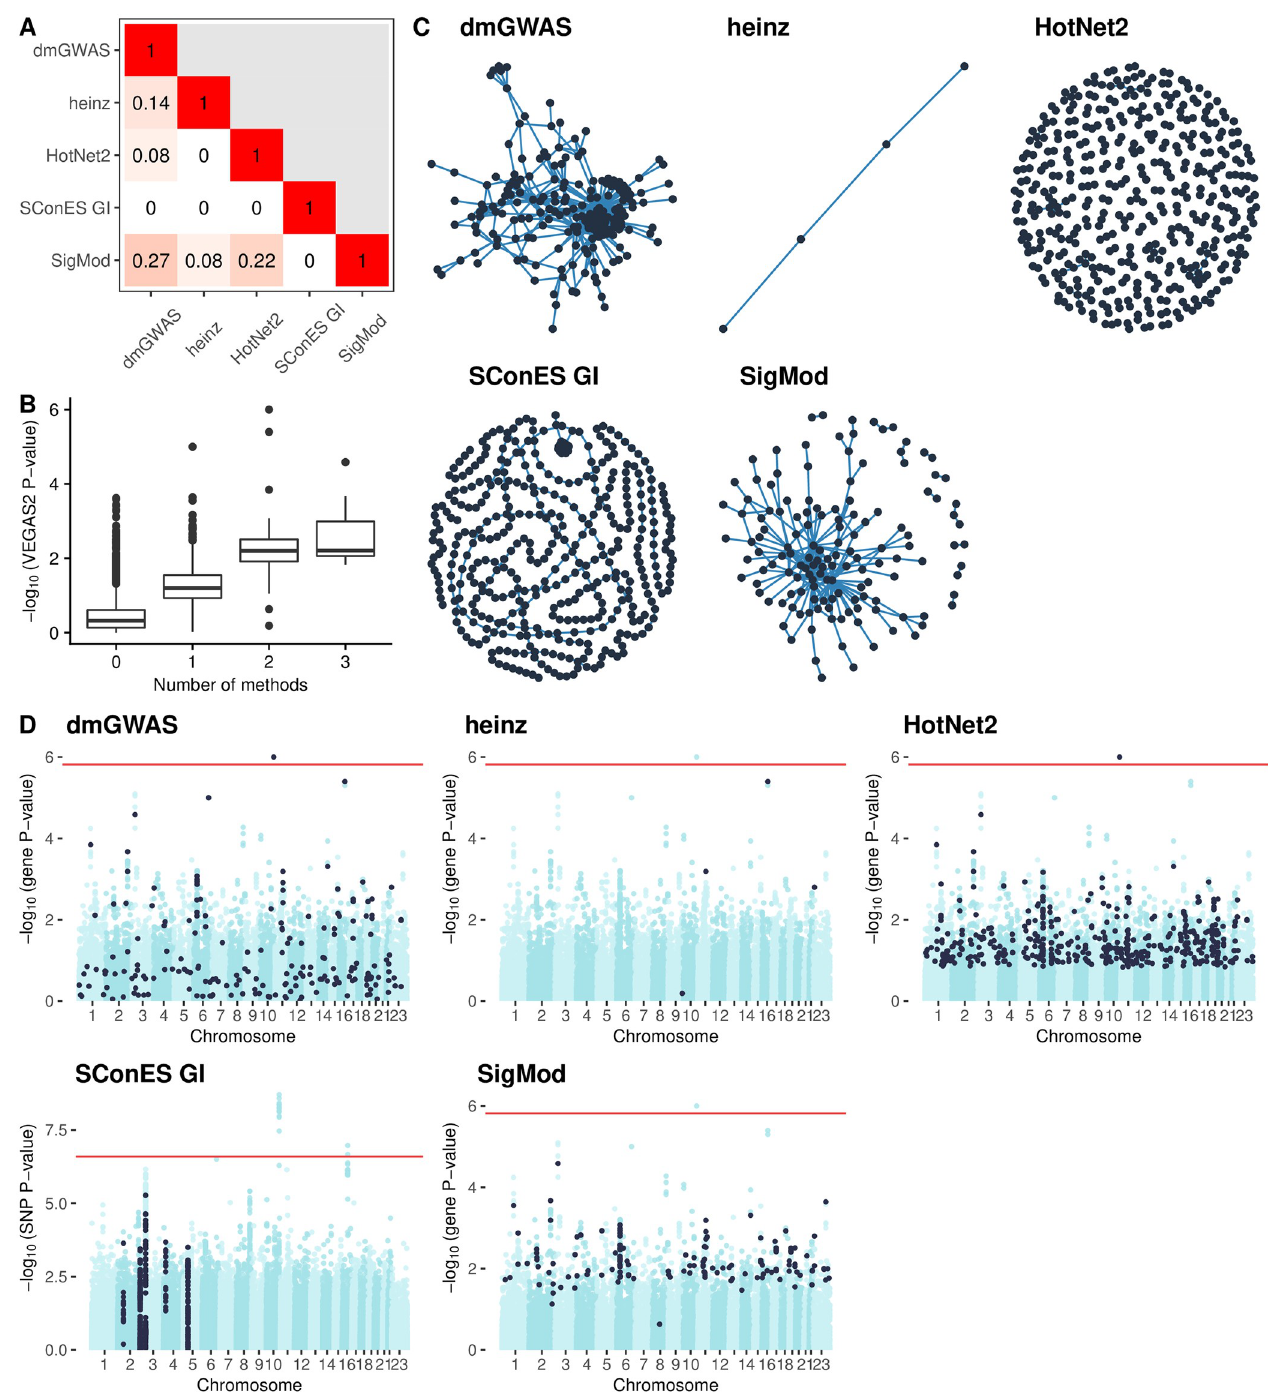
Fig 1. Overview of the solutions produced by the different network methods (Section 2.3.3) on the GENESIS dataset. As LEAN did not produce any significant solution (BH adjusted P-value < 0.05), it is not shown. Unless indicated otherwise, results refer to SNPs for SConES GI, and to genes for the other methods. (A) Overlap between the genes selected by each method, measured by Pearson correlation between indicator vectors (Sections 2.5.1 and 2.3.5). (B) Distribution of VEGAS2 P-values of the genes in the PPIN not selected by any network method (12 213), and of those selected by 1 (575), 2 (73), or 3 (20) methods. (C) Solution networks produced by the different methods. (D) Manhattan plots of SNPs/genes; in black, the method’s solution. The red line indicates the Bonferroni threshold (2.54 × 10 -7 for SNPs, 1.53 × 10 -6 for genes).